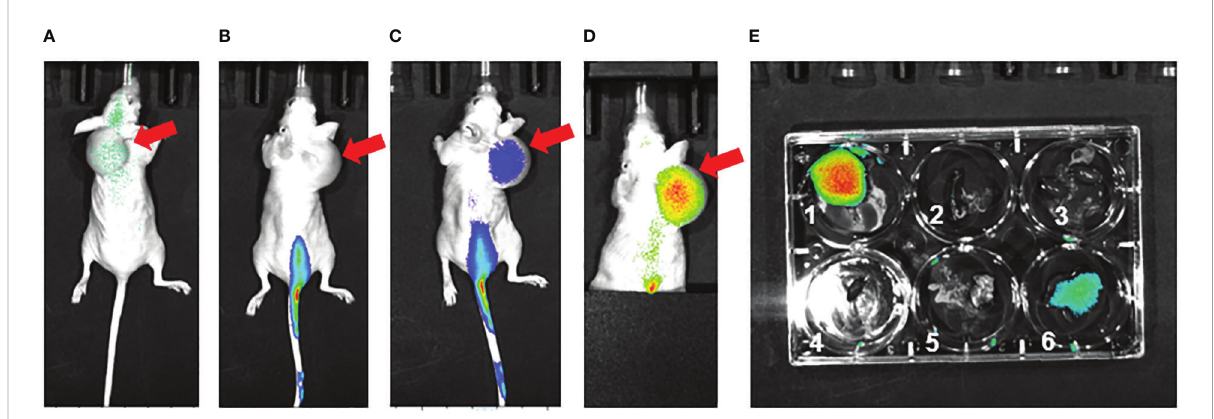
FIGURE 7 RAW.264.7 M1 polarized vesicles localize to SKOV3 tumor xenografts in vivo via an intravenous route. (A) Preinjection (0 hr – immediately prior to injection) of single athymic nude mouse with SKOV3 tumor xenograft in dorsal shoulder region (red arrow). The mouse was injected with 100 µl of fl uorescent dye-labeled vesicles and imaged (B) 24 hours post-injection and (C) 72 hours post-injection. There is clear fl uorescent uptake seen in the tumor. (D) 72 hours post-injection Tail vein covered to reduce emission background, displaying accentuated vesicle localization to the tumor 72 hours post injection. (E) Post-necropsy with 1=tumor, 2=spleen, 3=kidneys, 4=heart, 5=lungs, 6=liver; there is accentuated localization to the tumor. The size of the subcutaneous lesion resulted sagittal instability and displacement to the right over the time